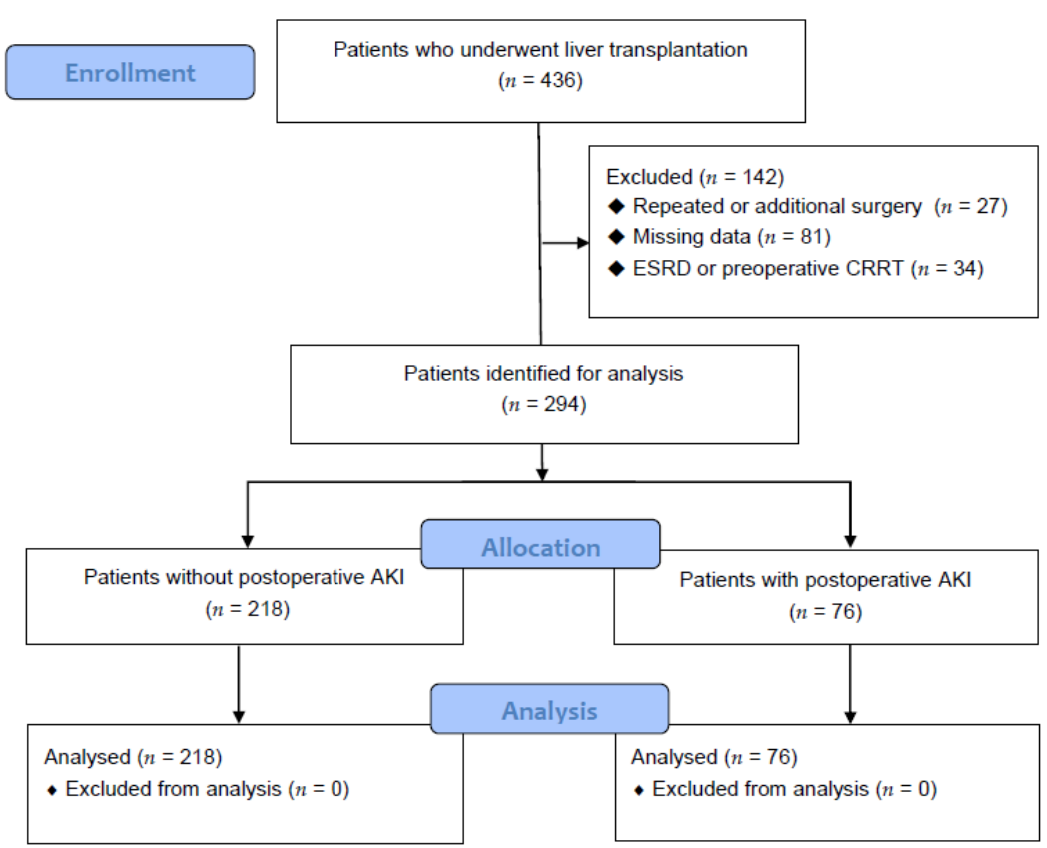
Figure 1. Flow diagram analyzing the e ff ect of ammonia on postoperative acute kidney injury in liver transplant patients.